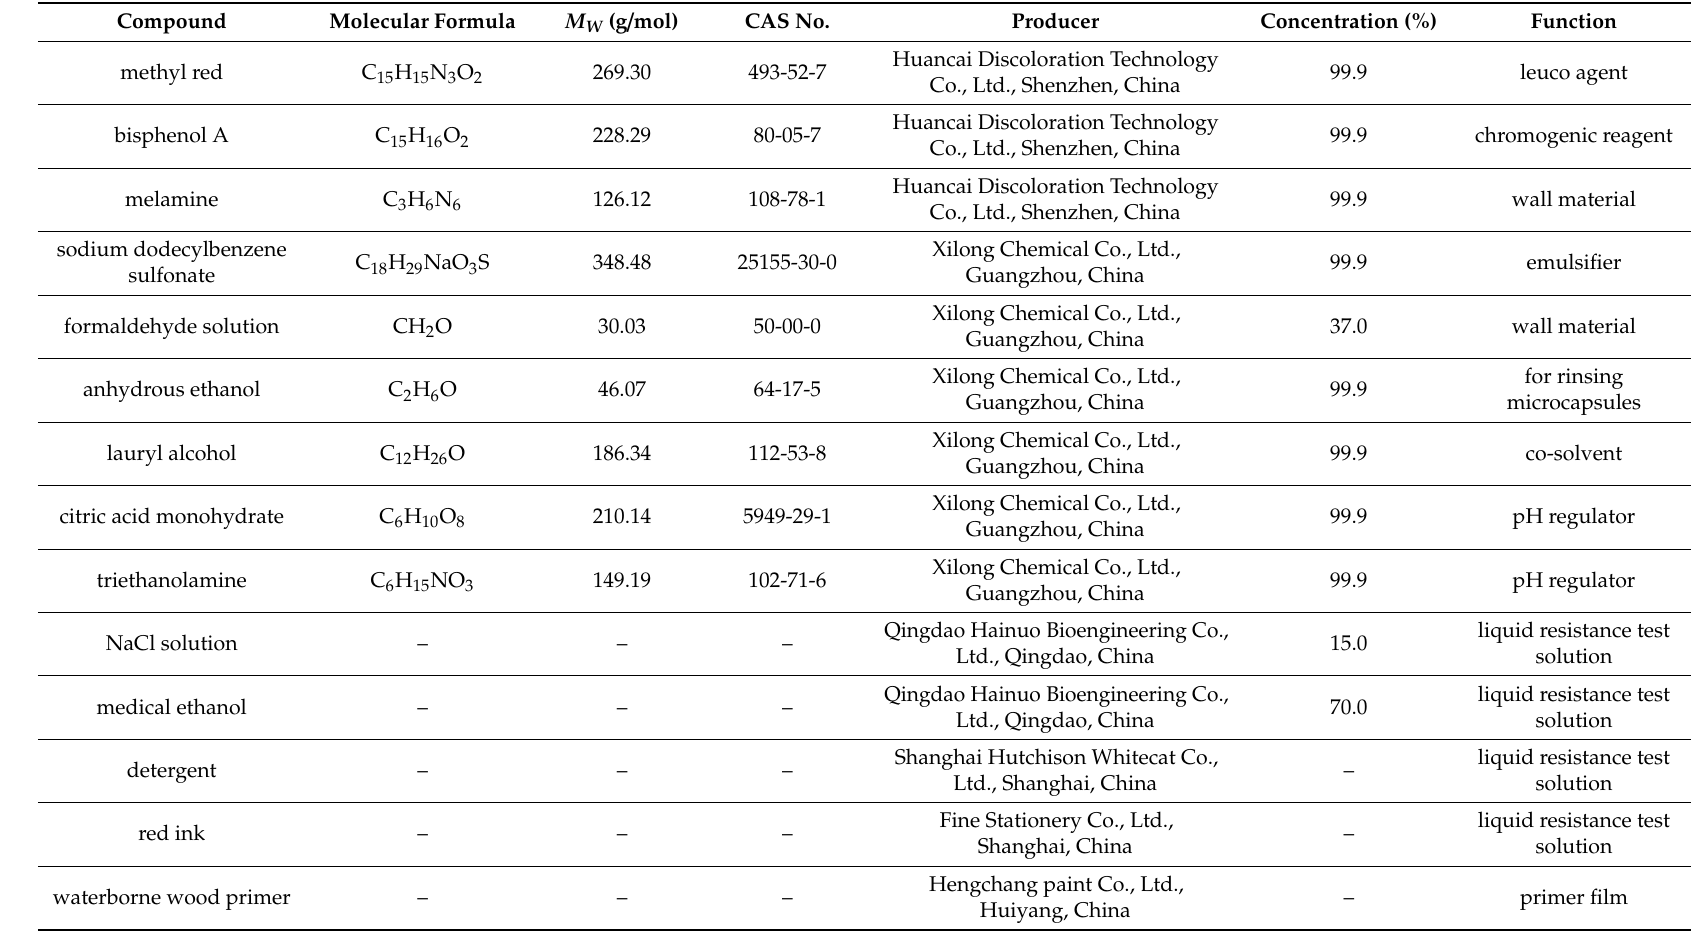
Table 1. Experimental